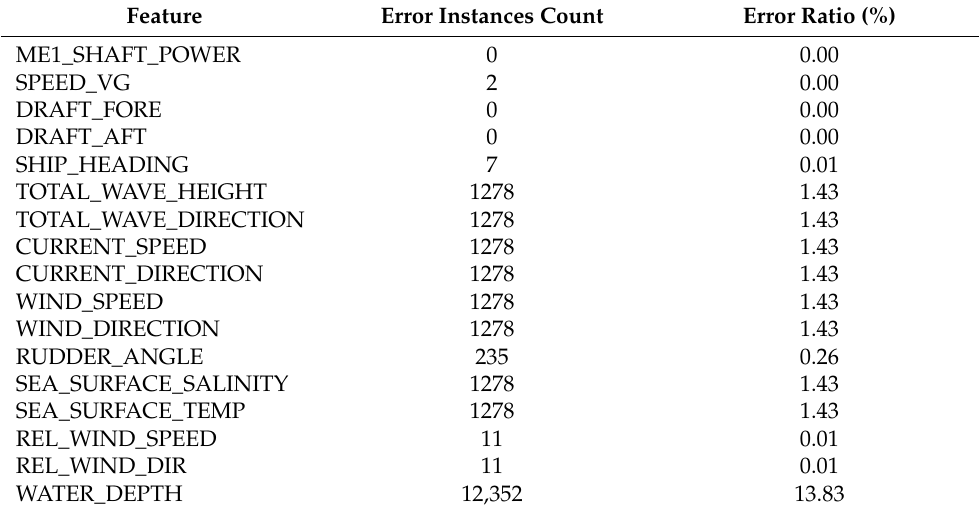
Table 4. Error data counts.